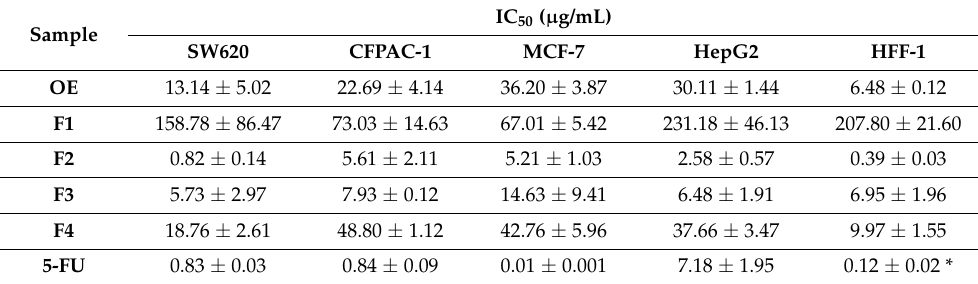
* Results obtained on lung fibroblast WI38. Values are expressed as mean value ± standard deviation of triplicate measurement.